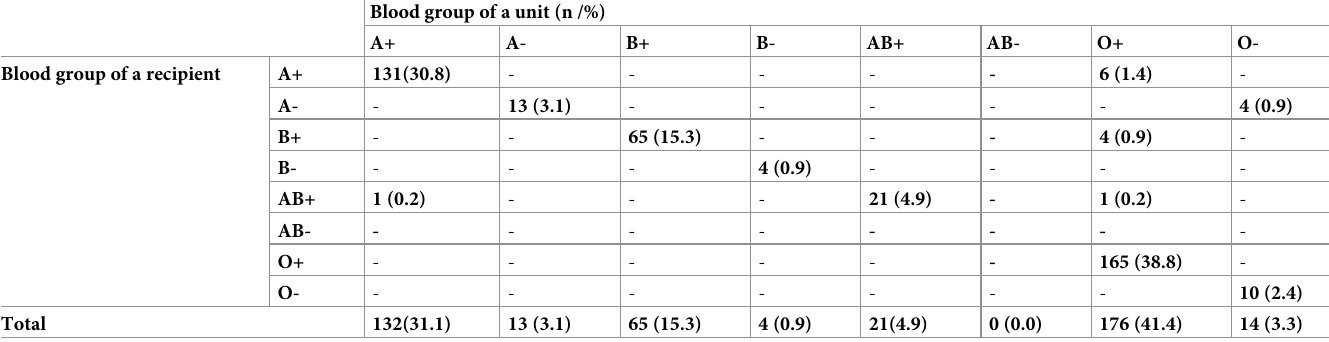
Table 3. Blood type distribution of recipient according to blood type transfused JMC, southwest Ethiopia, February 1 to June 30, 2018 (n = 425).